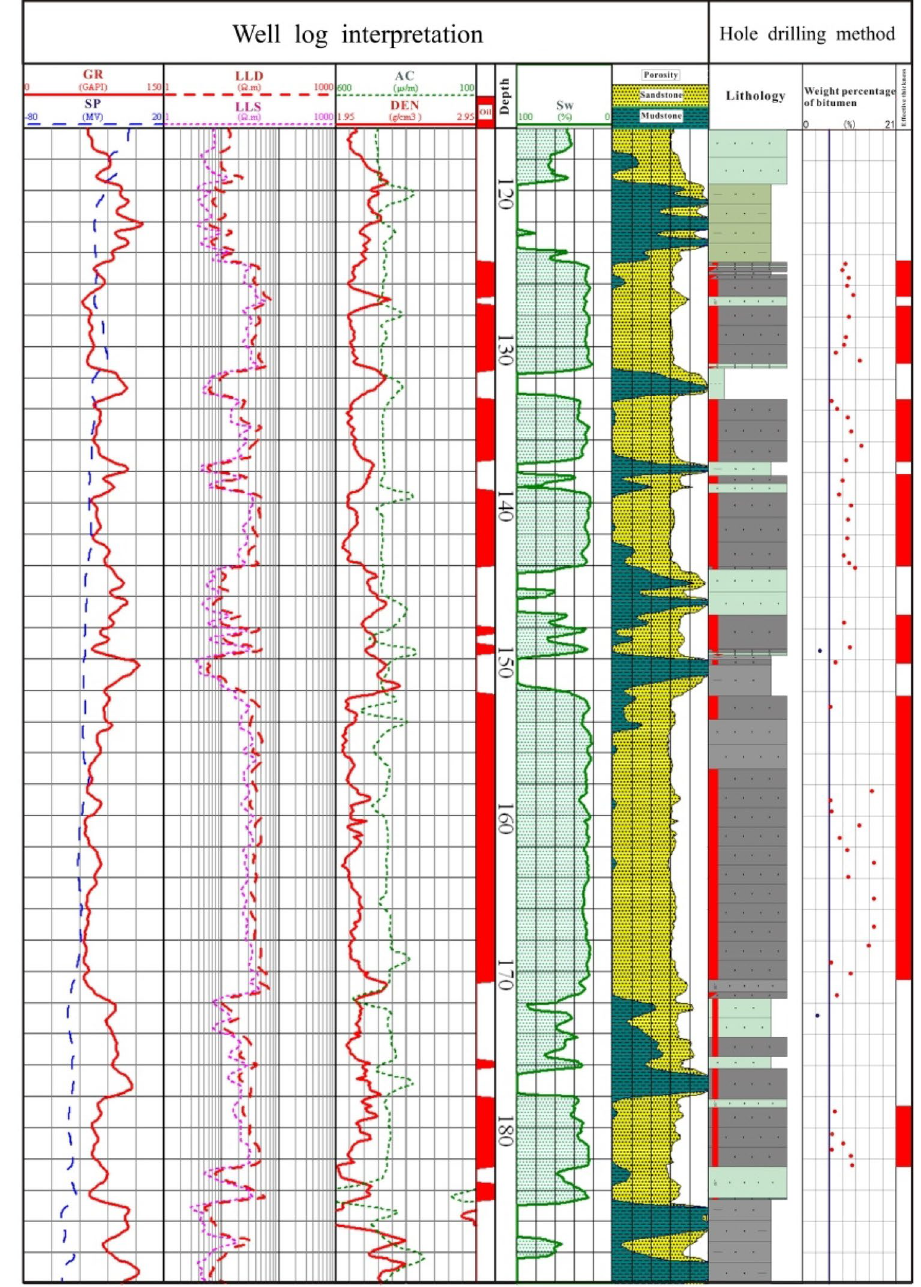
Fig. 7 Comparison of